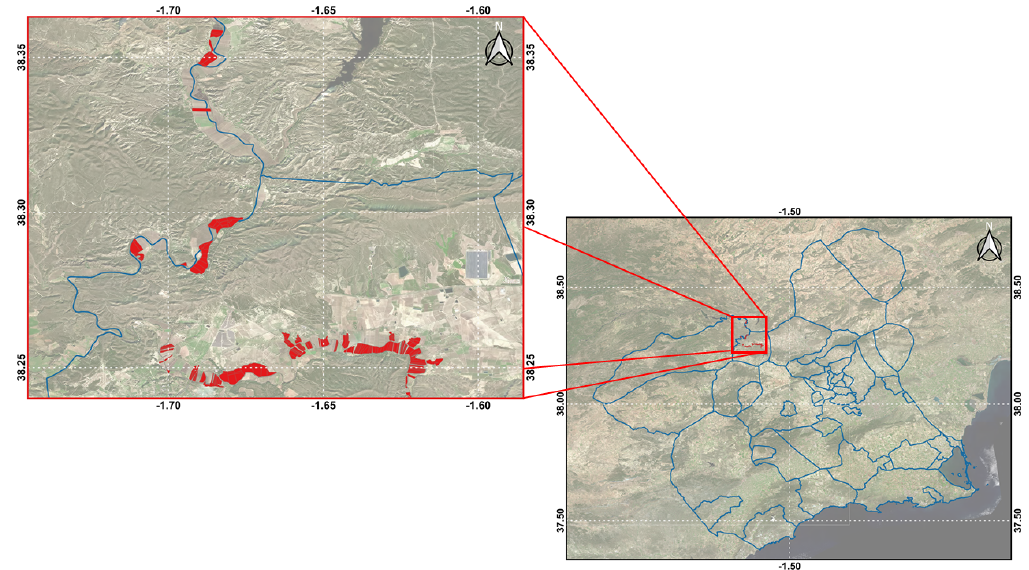
Figure 1. Coto Arrocero location in southeastern Spain and 2019 campaign help